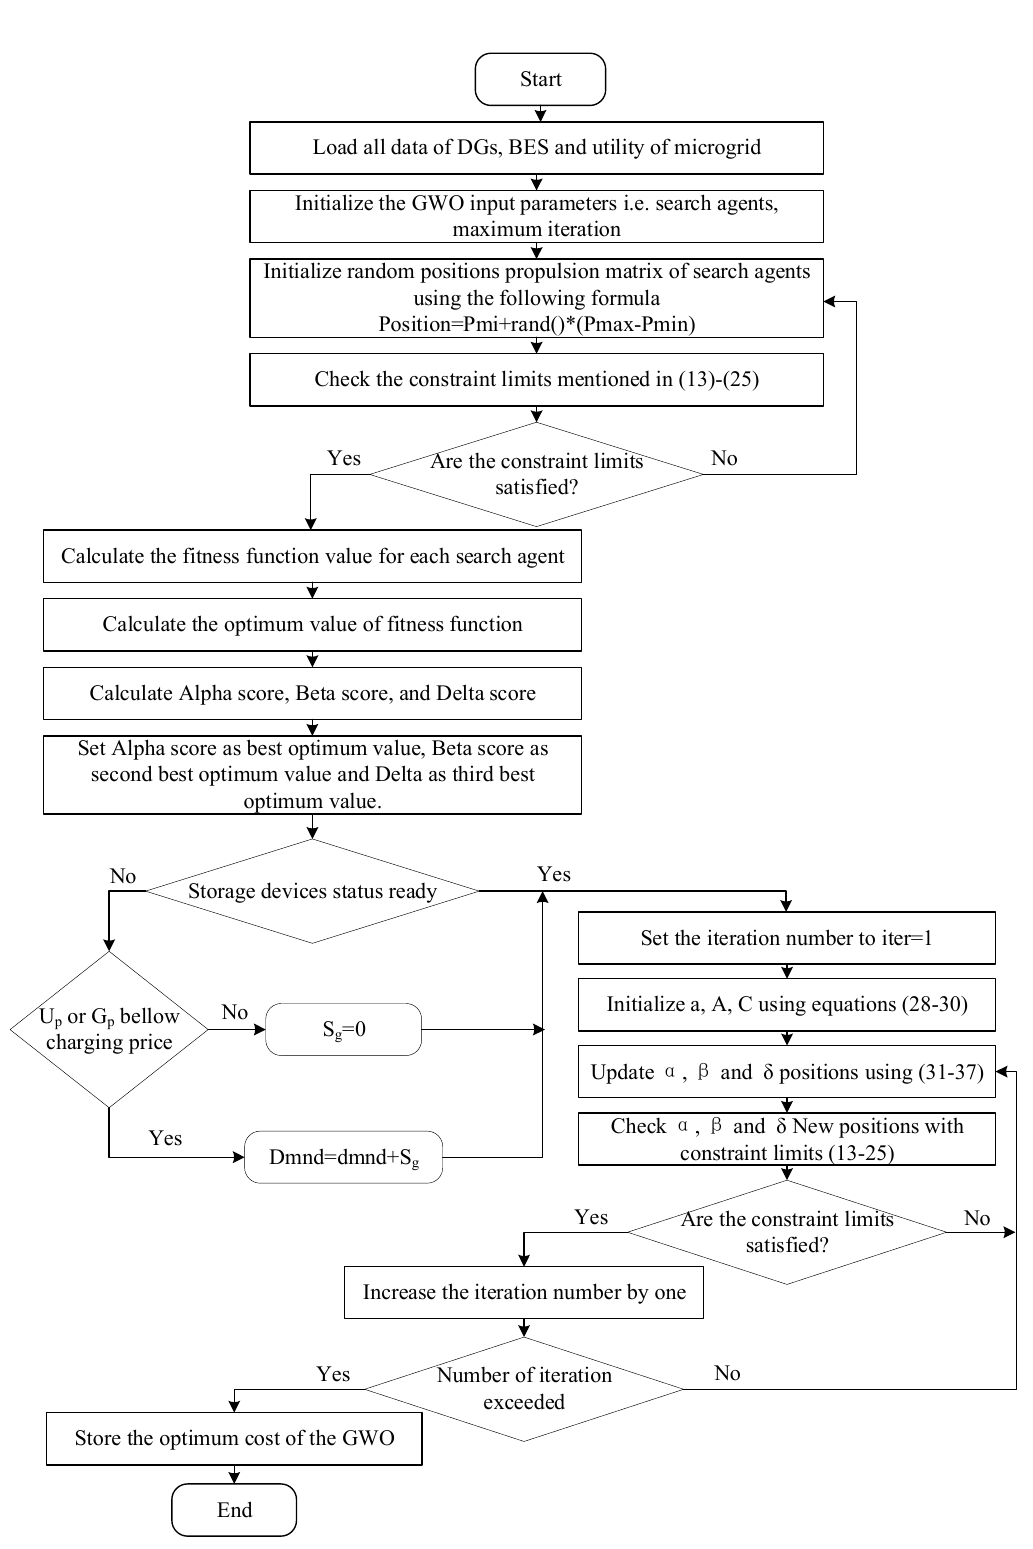
Figure 6. The flow chart of GWO implementation for microgrid management optimization.